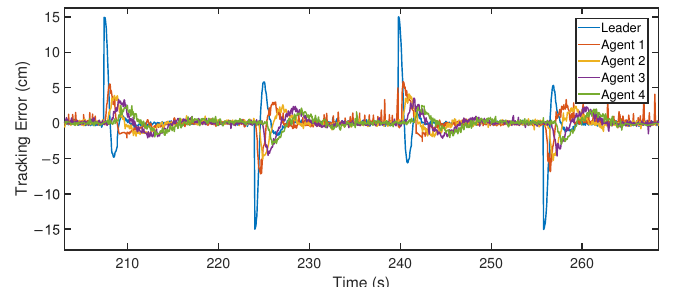
Figure 22. Results of the tracking error using the intermittent Kalman-filter strategy on the experi- mental PL-TOON platform. It can be observed that the vehicles behaved in a string-stable